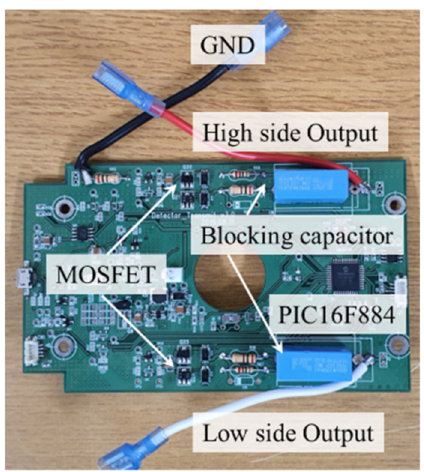
Figure 22. Transmitter for disconnection detection.